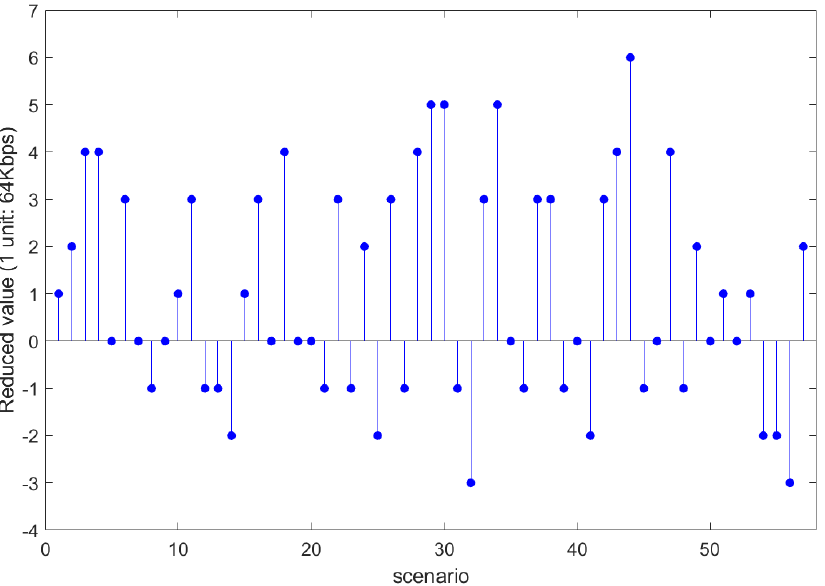
Figure 7 . The error distribution chart shows the difference between the coding bitrate estimated by the linear regression model and the original coding bitrate for each scenario. The positive reduced value means that the bitrates predicted by our model is better than those predicted by the original method. Each unit in the reduced value is 64 Kbps. Taking scenario 3 as an example, our method saves 256 Kbps.